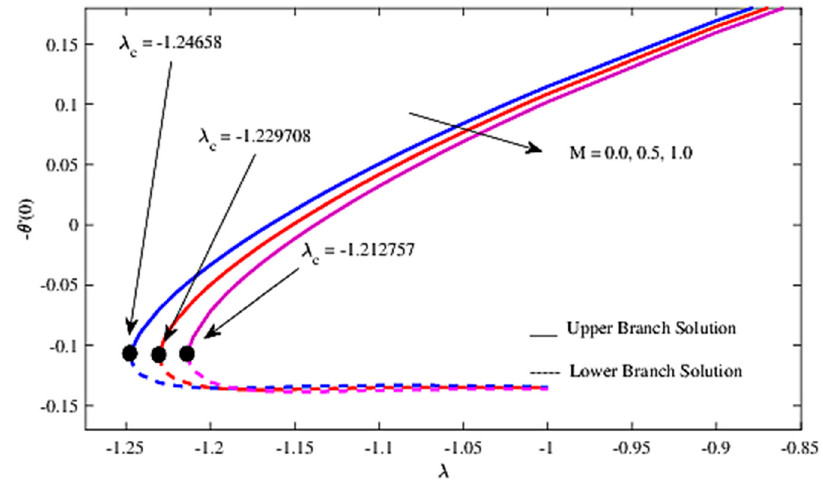
Figure 3. Variation of the Nusselt number − θ (cid:48) ( 0 ) with λ for di ff erent values of M with ε = 1000, Q = 0.1 and Pr = 1.0.